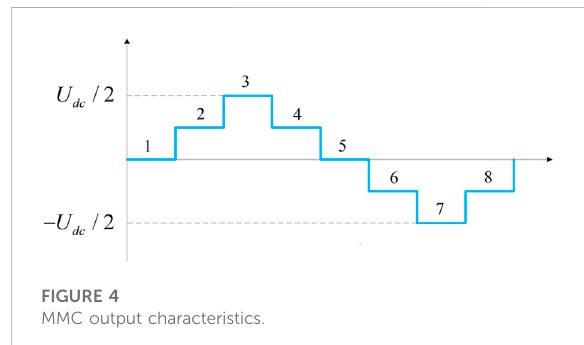
FIGURE 4 MMC output